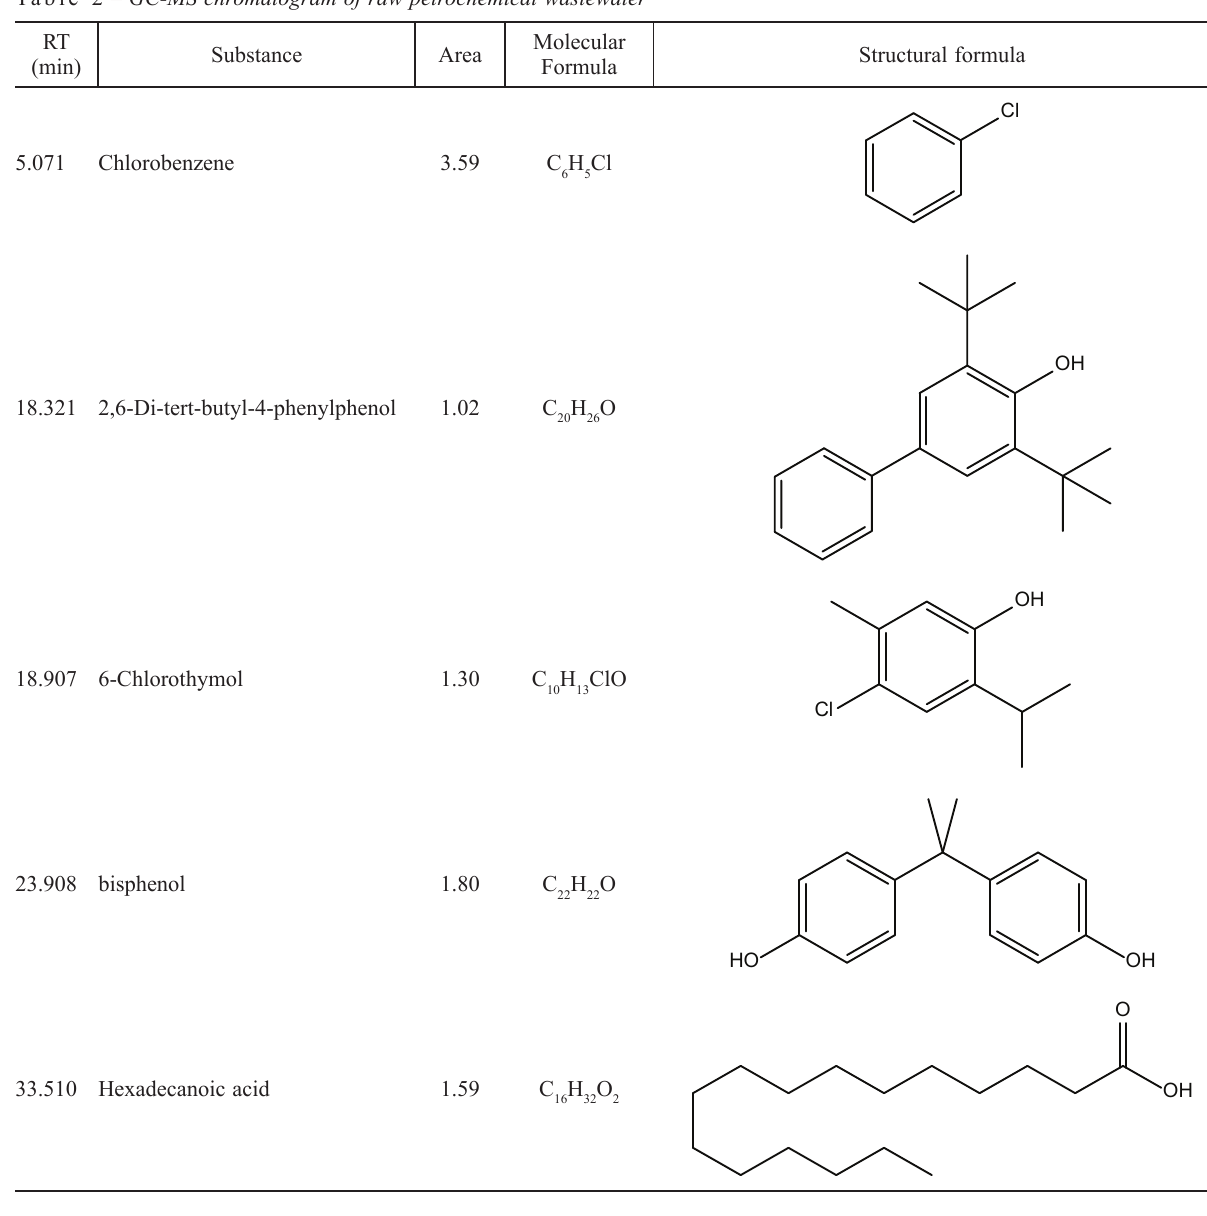
Table 2 – Gc-MS chromatogram of raw petrochemical wastewater RT